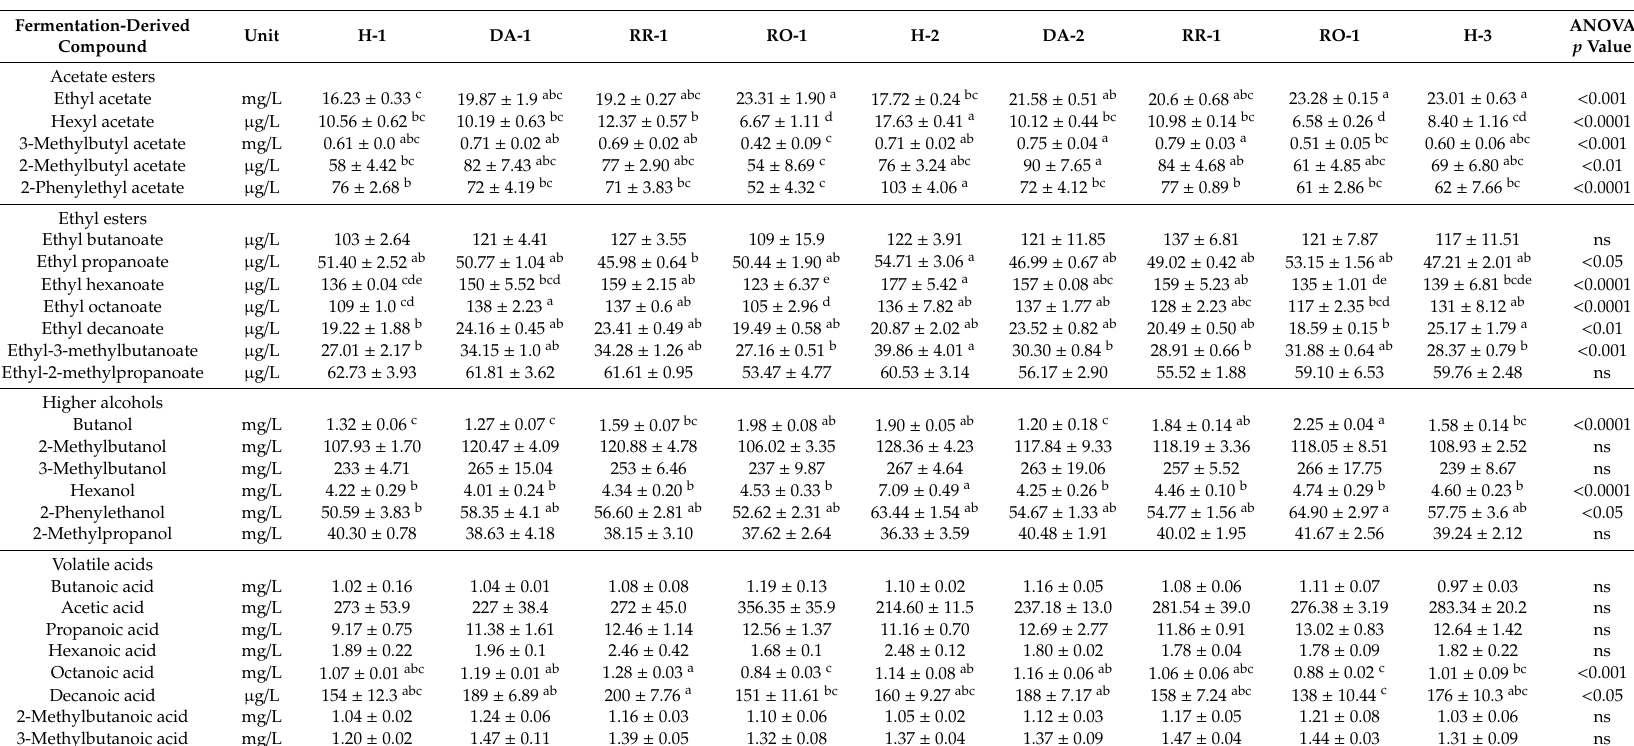
Table 3. Fermentation-derived compounds in Shiraz wines prepared following harvest time, saigne é and water addition treatments 12 months after fermentation † . Fermentation-Derived Compound